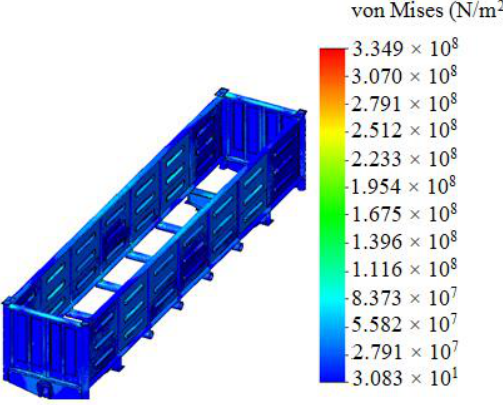
Figure 7. Deformations in carrying structure of open wagon ( a ) top view; ( b ) bottom view. It was established that foam aluminum applied as the filler for the center sill decreased the maximum equivalent stresses in the carrying structure of an open wagon by about 5% and displacements by 12% in comparison with those of the circular tube carrying structure of an open wagon without the filler (Figure 8).